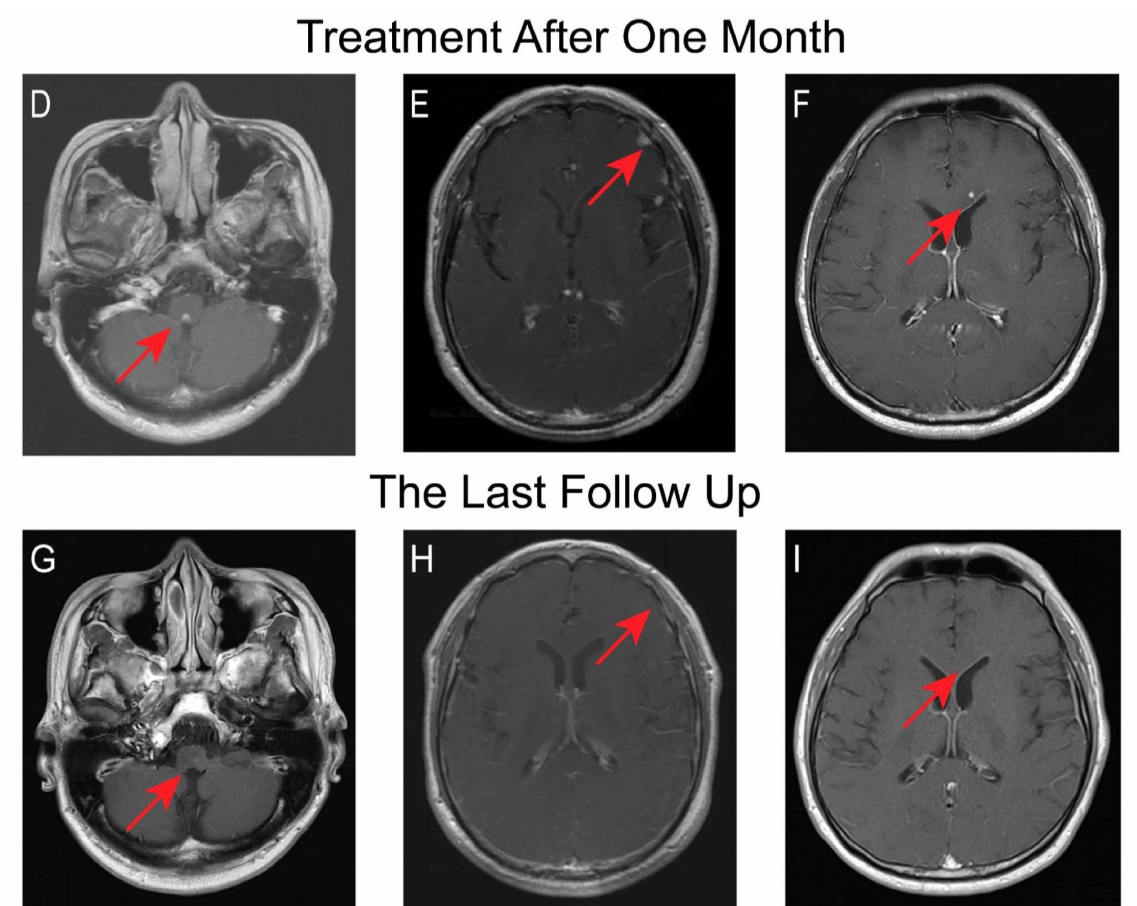
Figure 2. Changes of brain MRI before and after anti-tuberculosis treatment. The MRI sequence is Gd- enhanced MRI T1 cross-sectional; ( A – C ) The images of cases 1, 2, and 4 at admission. ( A ) Significant enhancement of pontine cistern as well as cerebellar vermis cistern. ( B ) No abnormal findings. ( C ) Scattered nodules of varying sizes in the brain parenchyma. ( D – F ) The images of cases 1, 2, and 4 after treatment for one month. ( D ) New nodular enhancement lesions were seen in the medulla oblongata in one patient. ( E ) Multiple new nodular enhancement lesions can be seen in the left frontal lobe of another case. ( F ) The lesions in the lateral ventricular angle were larger and more intense. ( G – I ) The images of cases 1, 2, and 3 after treatment for eight, three, and six months respectively. Follow-up imaging upon treatment showed resolution. ( G ) The lesions in the medulla oblongata of case 1. ( H ) The lesions in the left frontal lobe of case 2. ( I ) The lesions in the lateral ventricular angle of case